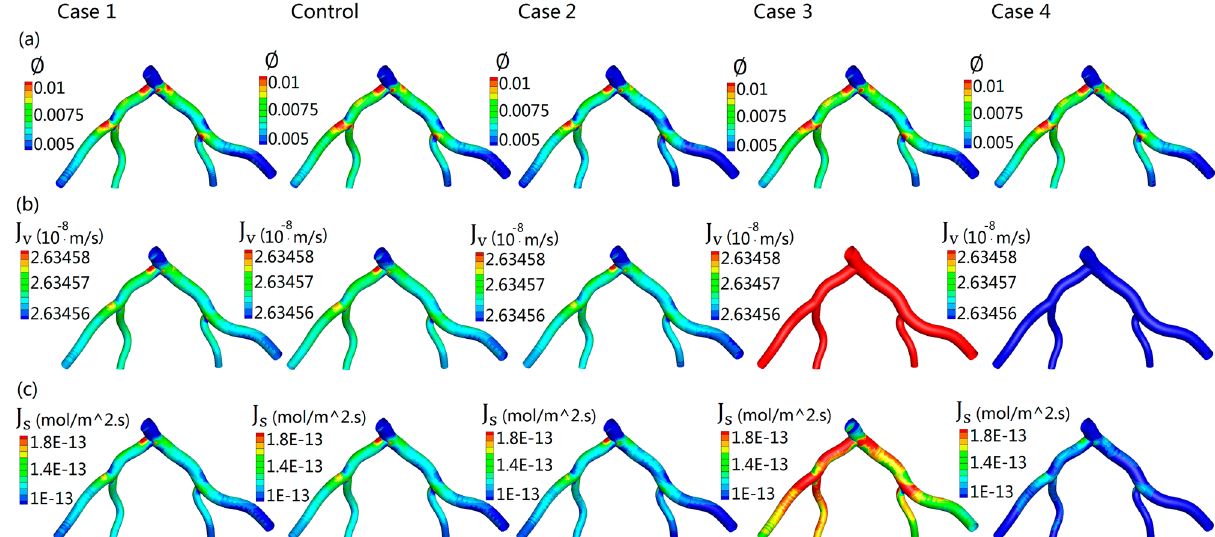
Figure 6. Three-pore model related indicators for the five simulations. ( a ) The distribution of the fraction of leaky junctions on endothelium ( ∅ ) of human left coronary arteries. ( b ) The distribution of total plasma volume flux ( J v ) through the endothelium. ( c ) The distribution of total mass flux of LDL ( J s cases, J v and J s are still showing significant differences among the five different cases, especially case 3 (increased blood pressure) and case 4 (increased wall thickness). The distribution of the percentage difference of the J v and J s on the luminal wall. Figure 7a,b respectively shows the percentage difference of J v ( J ′ v ) and J s ( J ′ s ) between Case (1, 2, 3, 4) and Control case. The relatively high values of J ′ v between rigid and elastic models (Case 1 vs. Control) are located at the regions of